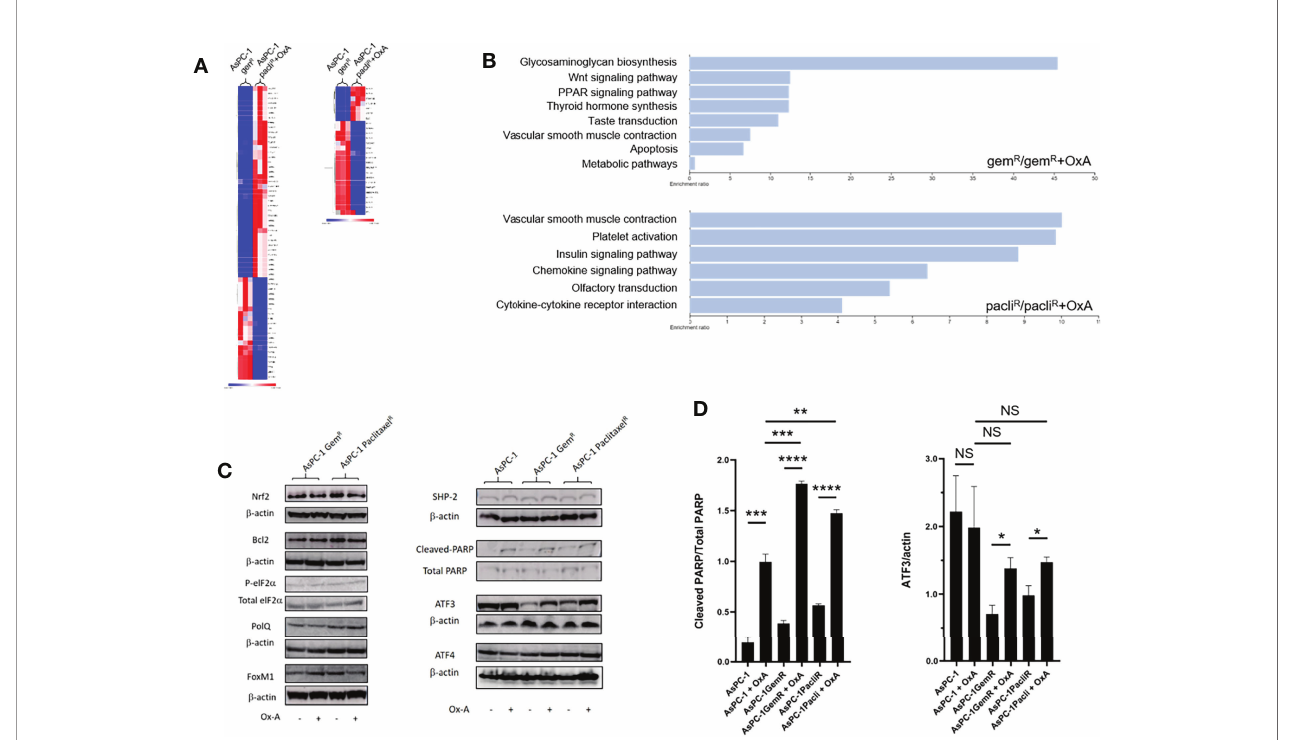
FIGURE 7 | RNA-seq and Western blot analysis of gemcitabine- and Nab-paclitaxel-chemoresistant tumors treated or not by OxA. (A) Heatmap of mRNA expression in gemcitabine- and Nab-paclitaxel-chemoresistant tumors treated or not by OxA. (B) Diagram of functional enrichment analysis of mRNA expression in gemcitabine- and Nab-paclitaxel-chemoresistant tumors treated or not by OxA. (C) NrF2, Bcl2, p-elF2 a , PolQ, FoxM1, SHP-2, cleaved-PARP, ATF3, and ATF4 factor expression in gemcitabine- and Nab-paclitaxel-chemoresistant tumors treated or not by OxA. (D) Semi-quantitative analysis of cleaved-PARP and ATF3 expression in gemcitabine- and Nab-paclitaxel-chemoresistant tumors treated or not by OxA, determined by Western